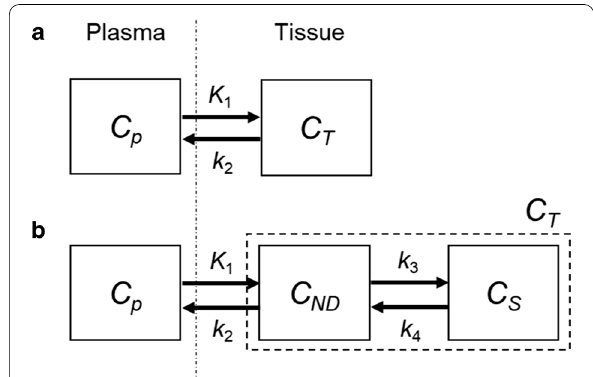
Fig. 1 Compartment models for kinetic analysis. a a one-tissue, two-compartment (1T2C) and b a two-tissue, three-compartment (2T3C)